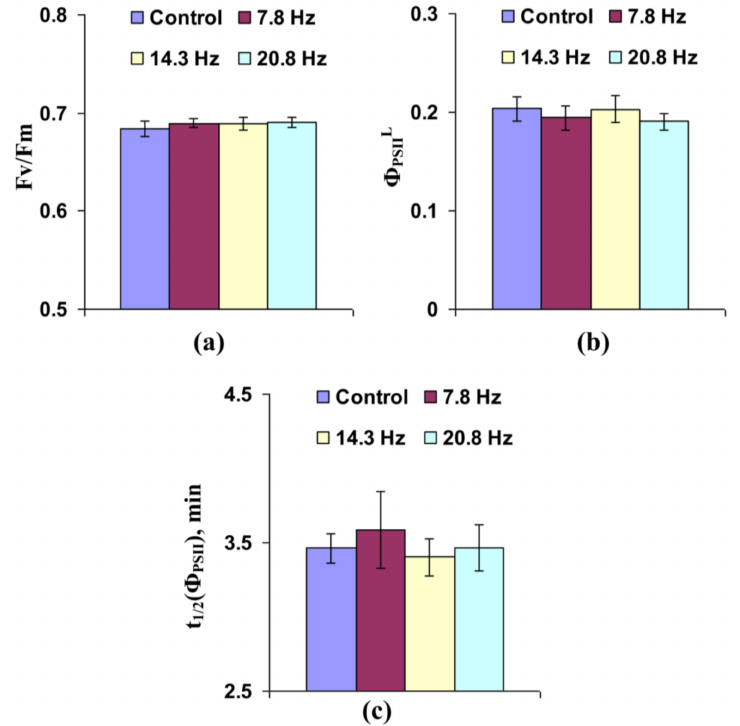
Figure 5. Influence of short-term treatment by artificial extremely low frequency magnetic field on potential quantum yield of photosystem II (Fv/Fm) ( a ), effective quantum yield of photosystem